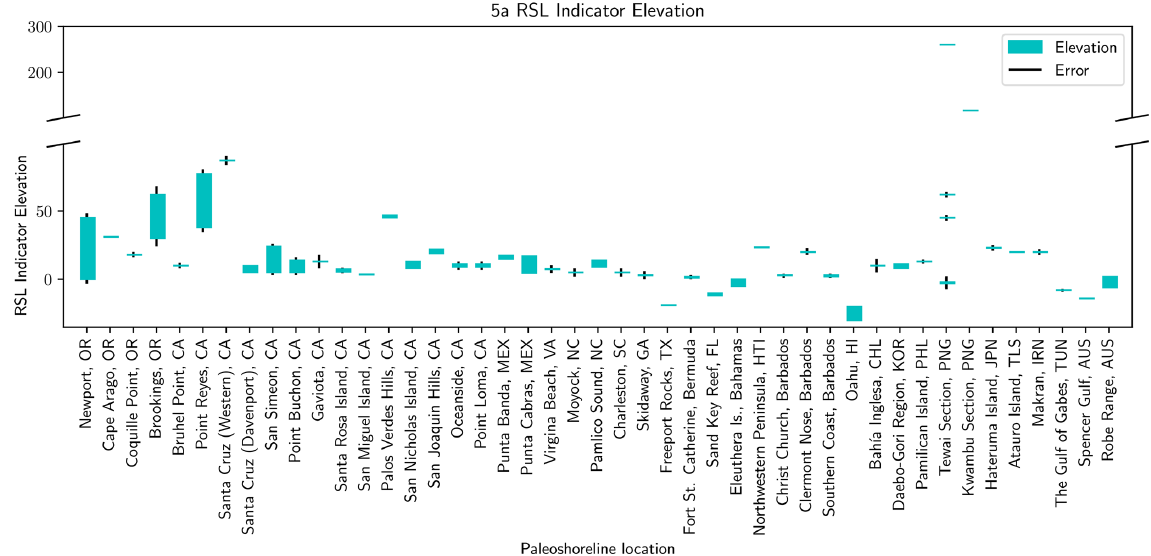
Figure 2. The present elevation of MIS 5a RSL indicators, in meters, at the field locations listed on the horizontal axis. Teal bars represent the full elevation range reported in the primary publications along with the corresponding measurement error, if any, in black bars. Note the scale break on the vertical axis necessary to present indicator elevations for sites with rapid tectonic uplift.